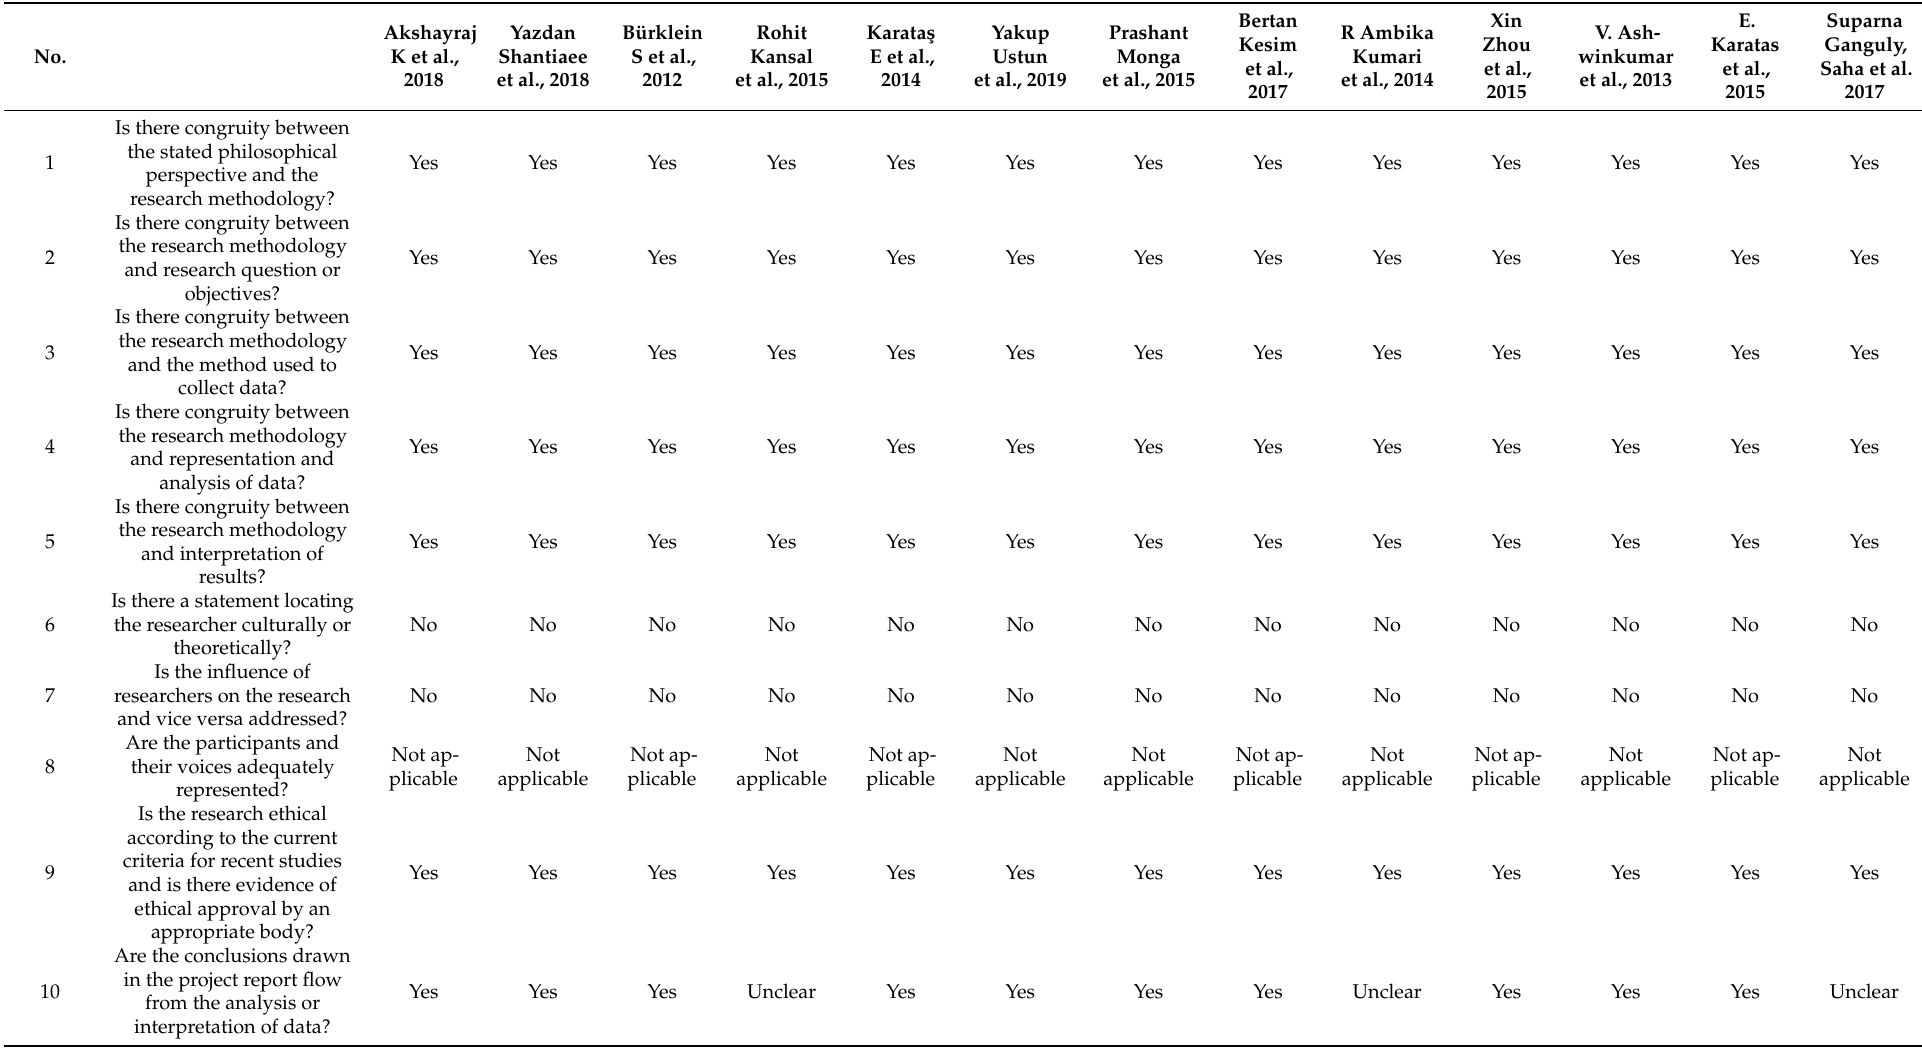
Table 5. Joanna Briggs’ quality assessment